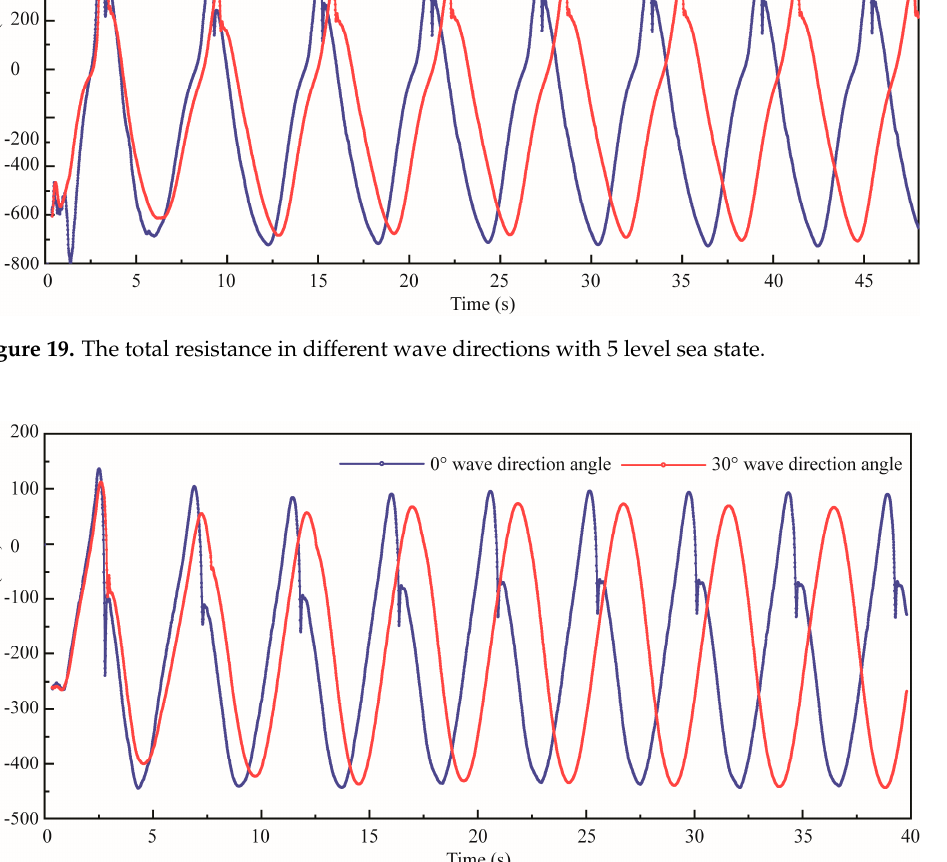
Figure 20. The total resistance in different wave directions with 7 level sea state.